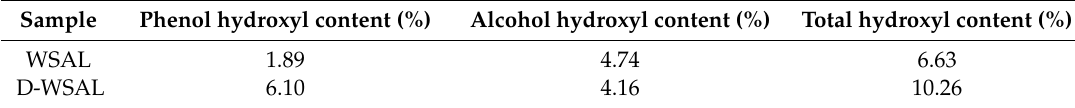
Table 7. Phenolic hydroxyl and alcohol hydroxyl contents of WSAL or D-WSAL.